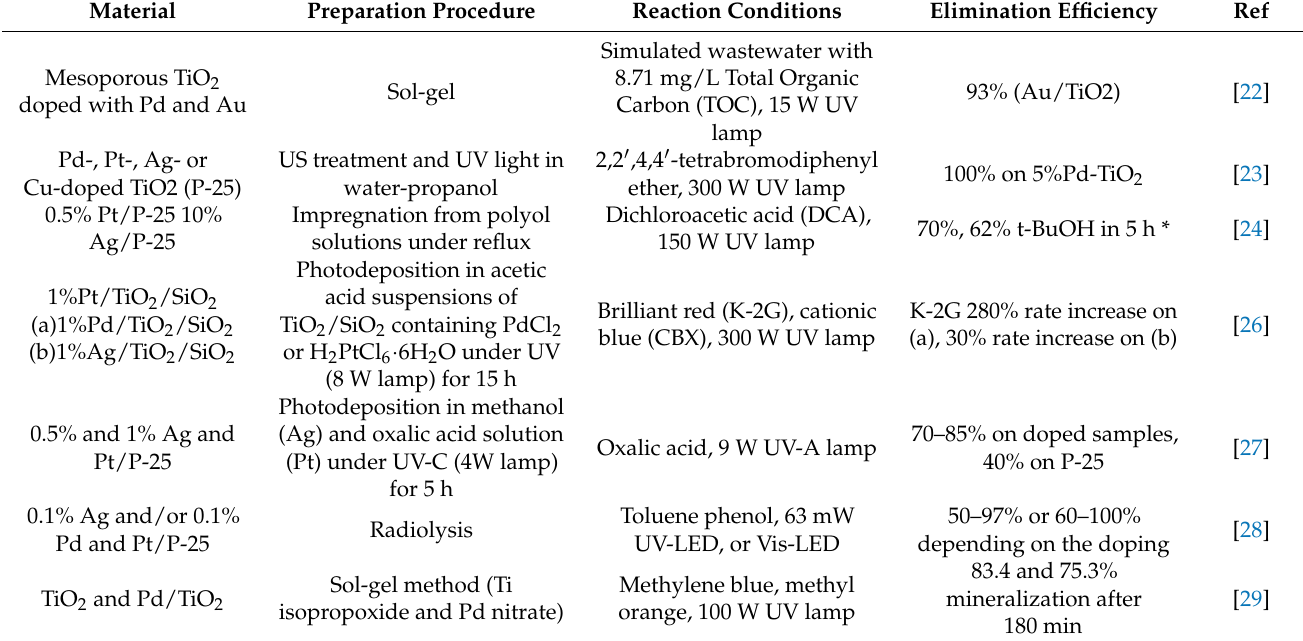
Table 1. Photocatalytic performance of noble metal-doped TiO